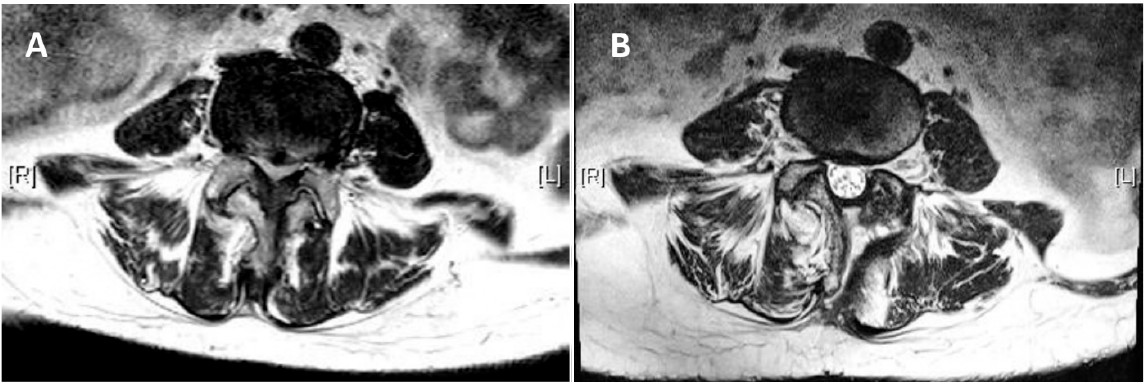
Figure 6. MRI follow-up at 12 months for a 61-year-old female with a diagnosis of L4-5 spinal stenosis. ( A ). A preoperative MRI shows a severe spinal stenotic lesion at L4-5. ( B ). Postoperative MRI showing full decompression of the spinal canal.